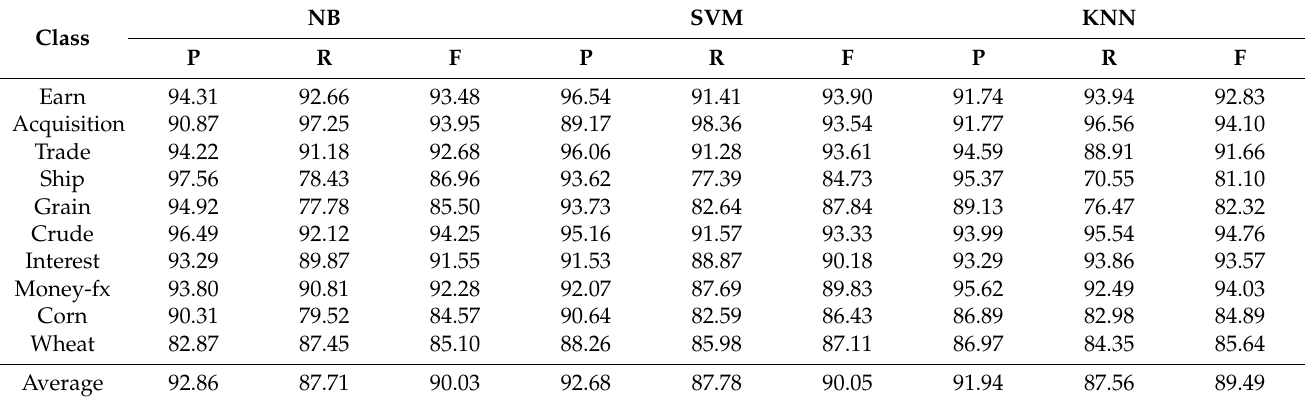
Table 13. Precision (P), Recall (R) and F-measure (F) of each class in the Reuters dataset using BBA CO .